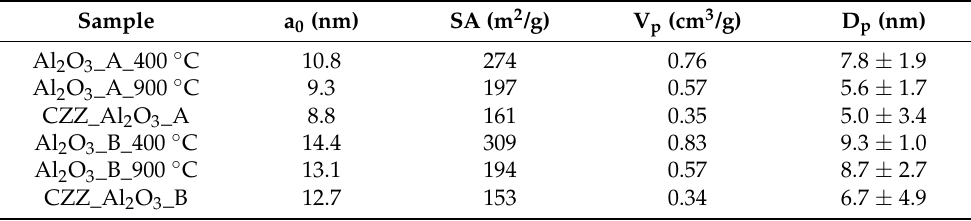
Table 1. Cell parameter (a 0 ), BET surface area (SA), pore volume (V p ), and mean BJH pore diameter (D p ) of the two series of samples Al 2 O 3 _A (from P123) and Al 2 O 3 _B (from F127).